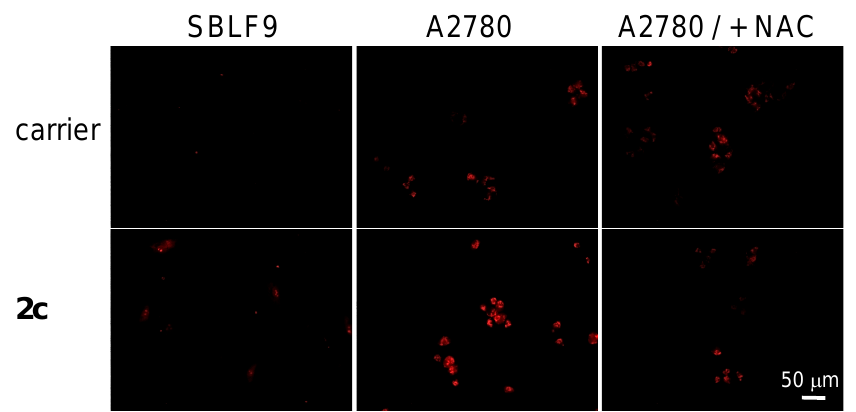
Figure 6. Effect of carrier (DMSO, 1%, v / v ) and prodrug 2c (5 µM) (both incubated with the cells for 24 h) on mROS (stained using MitoSOX probes) in representative normal cells (SBLF9) and cancer cells (A2780). As indicated on the plot, in some cases N -acetylcysteine (NAC, 5 µM) was co-incubated with the carrier and the prodrug. Images obtained for the “carrier” and “2c” probes were compared qualitatively.